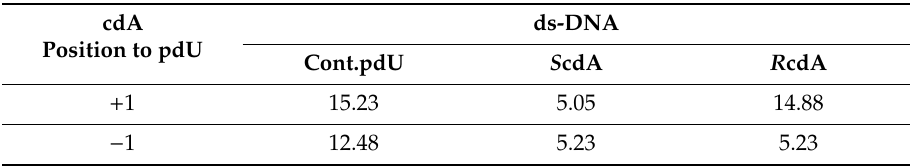
Table 4. Next to UDGs’ active site AT base pair hydrogen bond energy, in kcal, presented in Figure 2F, calculated at the B3LYP / 6-31G ** level of